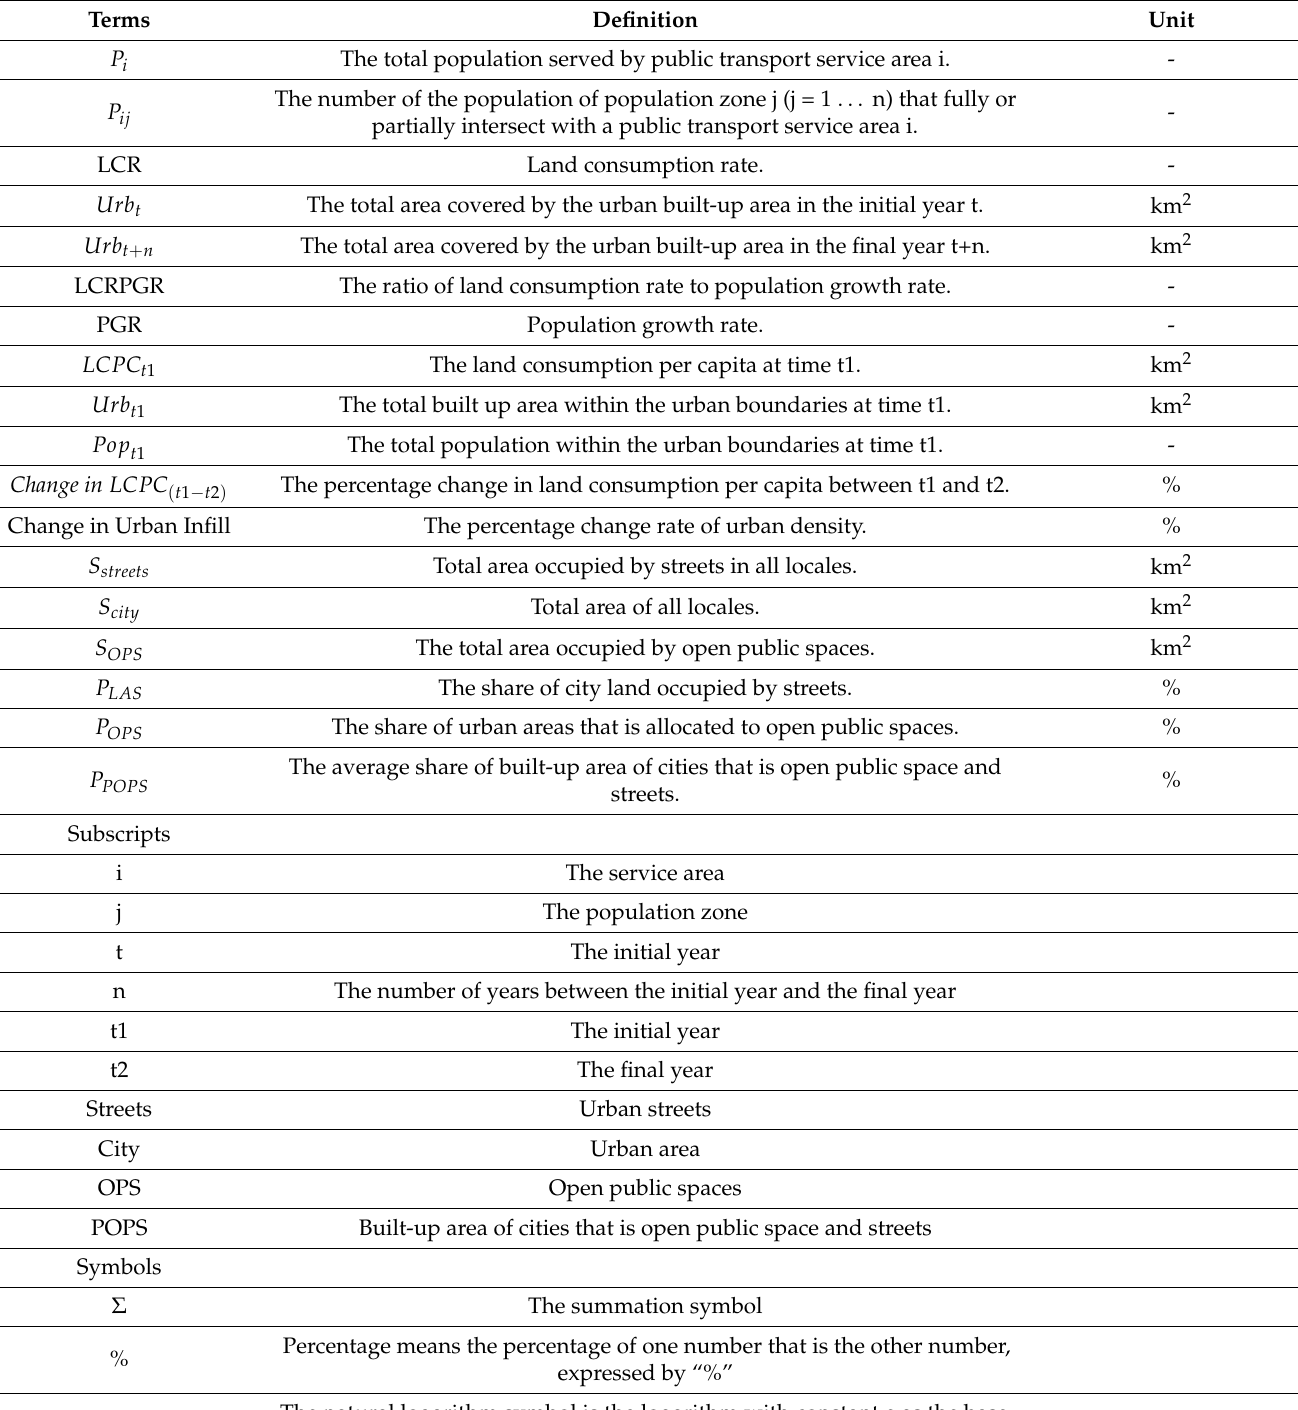
Table 3. Notations used in this